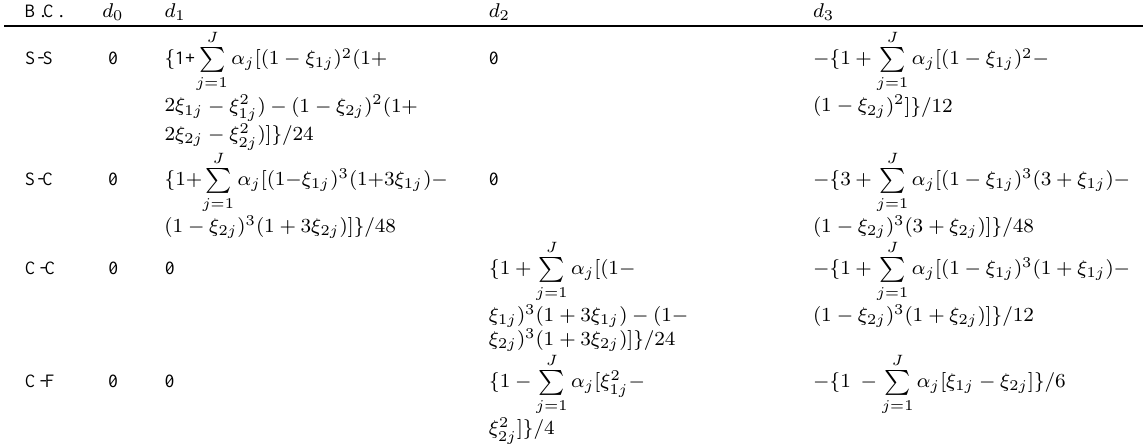
Table 1 The coefficients d i ( i = 0 , 1 , 2 , 3 ) in Eq. (20) for different boundary conditions